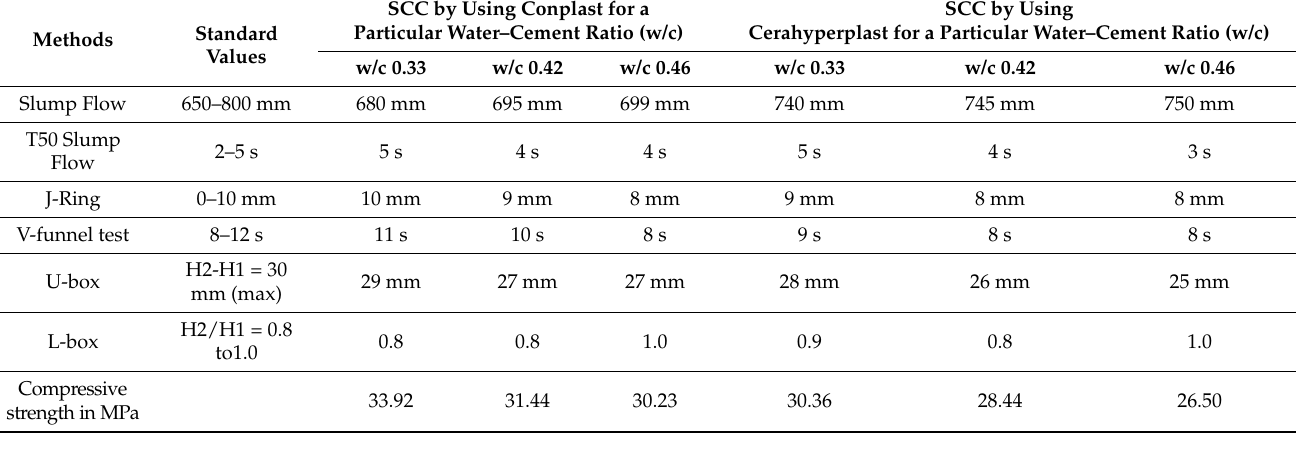
Table 2. Fresh and hardened properties of concrete.